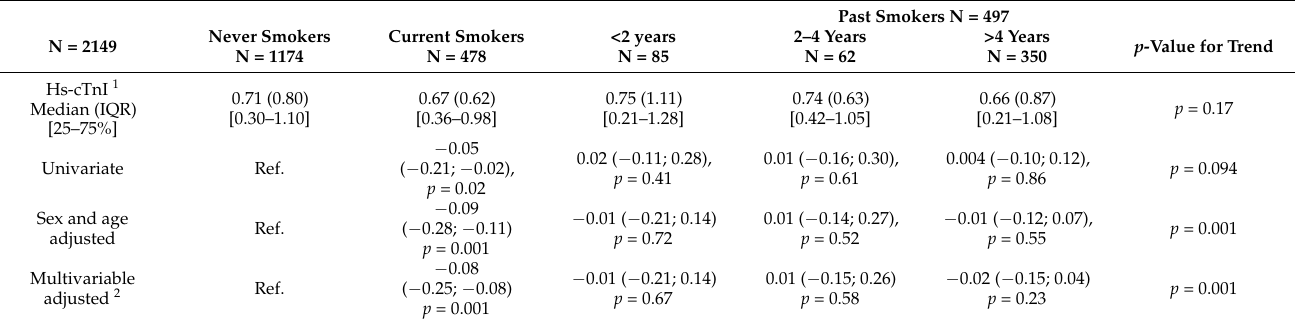
Table 5. Results of the relationship between smoking cessation and